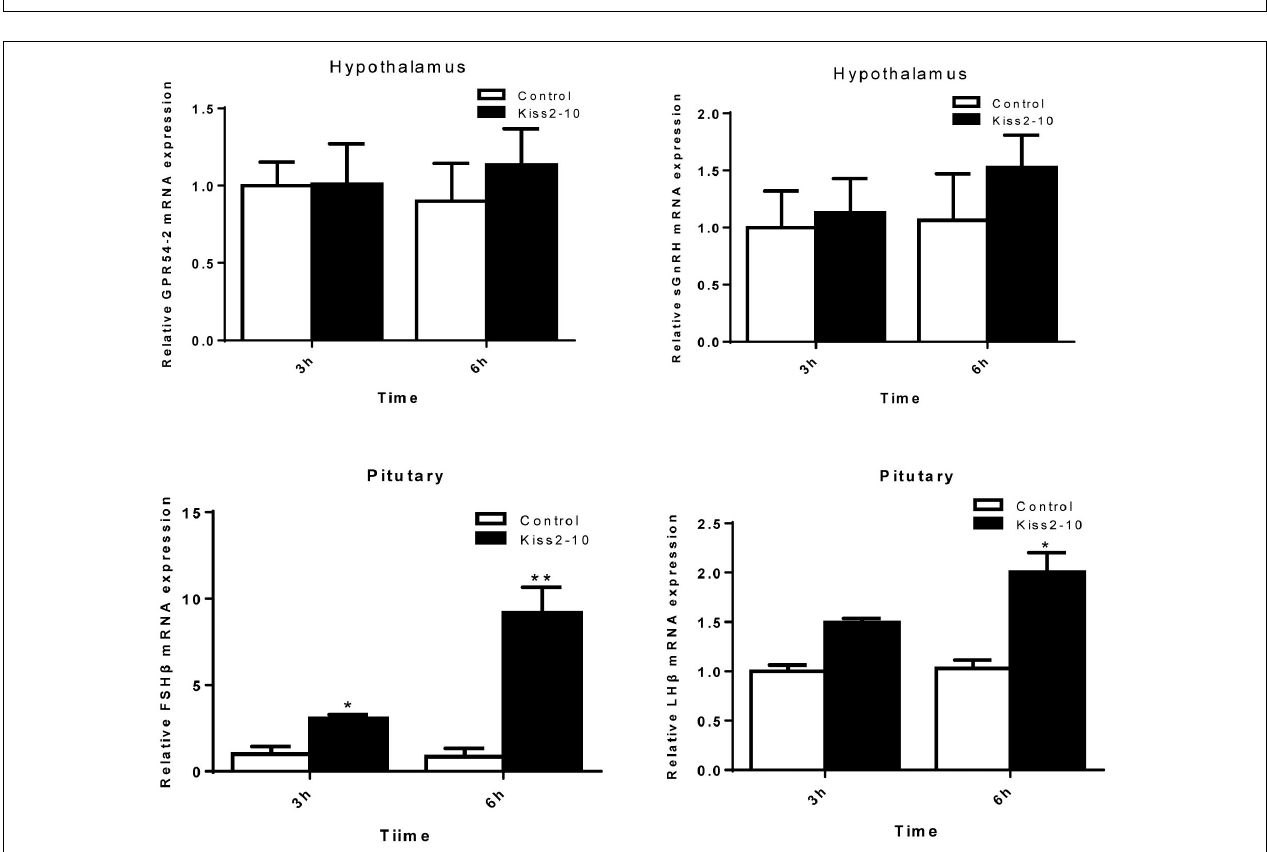
FIGURE 8 | Effects of administration of seahorse Kiss2-10 on the gene expressions for GPR54-2, sGnRH, FSH β , and LH β at 3 and 6 h post-injection in sexually mature male lined seahorses. The mRNA expression levels were identified by real-time PCR, normalized against the β -actin transcript, and presented as means ± SEM. Asterisks denote significant differences between different treatments ( P <